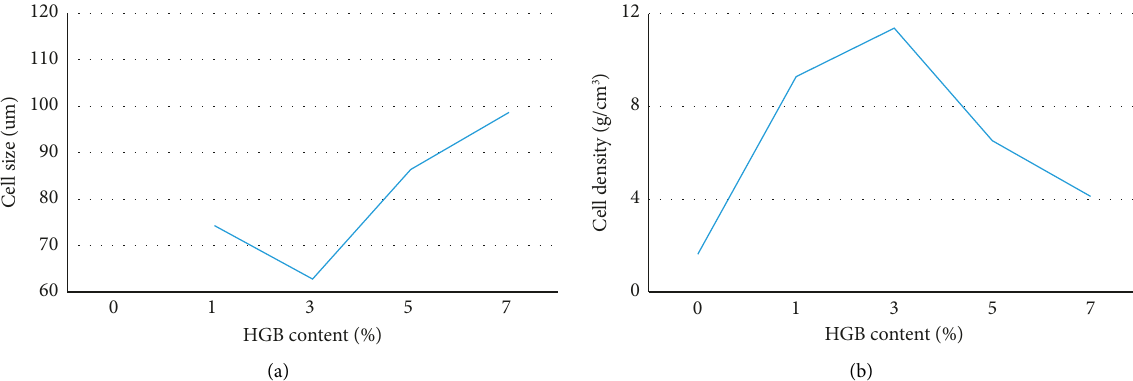
Figure 9: Graph of cell size and cell density of foamed samples under different HGB contents. (a) The effect of different HGB content on the cell size of the sample. (b) The effect of different HGB content on the cell density of the